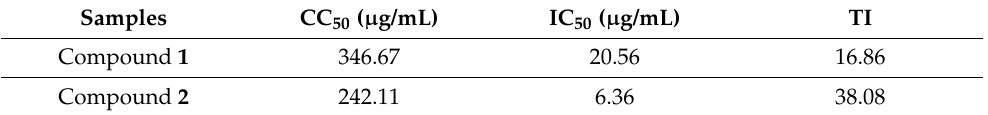
Table 2. Results of cytotoxicity (CC 50 ), anti-HBV activity (IC 50 ), and their corresponding therapeutic index (TI) of compounds 1 and 2 . Values are the means of 3 determinations.